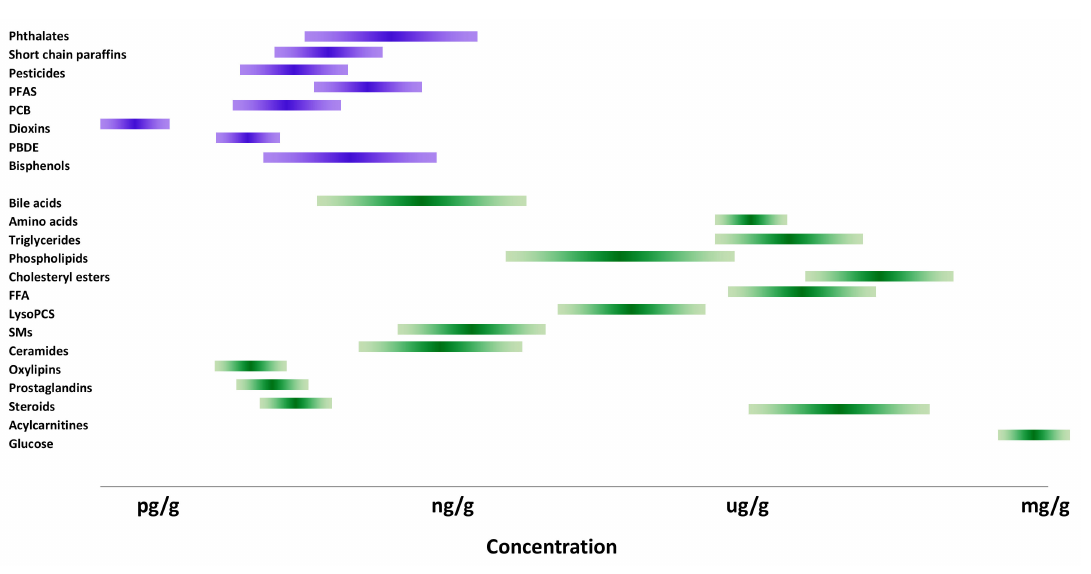
Figure 1. Plasma concentration ranges of the most common persistent organic pollutants (POPs) and